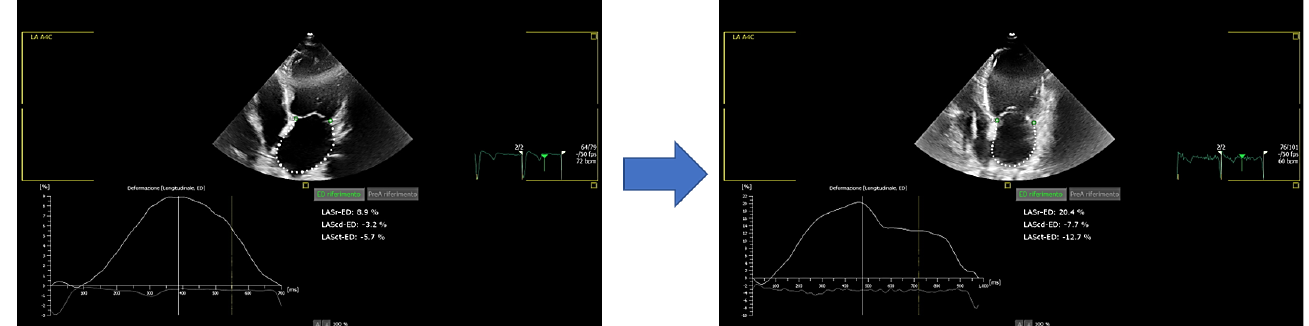
Figure 2. Left atrial strain improvement after 6-month therapy with Sacubitril/Valsartan. LASr-ED: left atrial strain reservoir phase at end-diastole, is the equivalent of PALS. LAScd-ED: left atrial strain conduit phase at end-diastole, is the equivalent of left atrial conduit strain. LASct: left atrial strain contraction phase at end-diastole, is the equivalent of PACS.